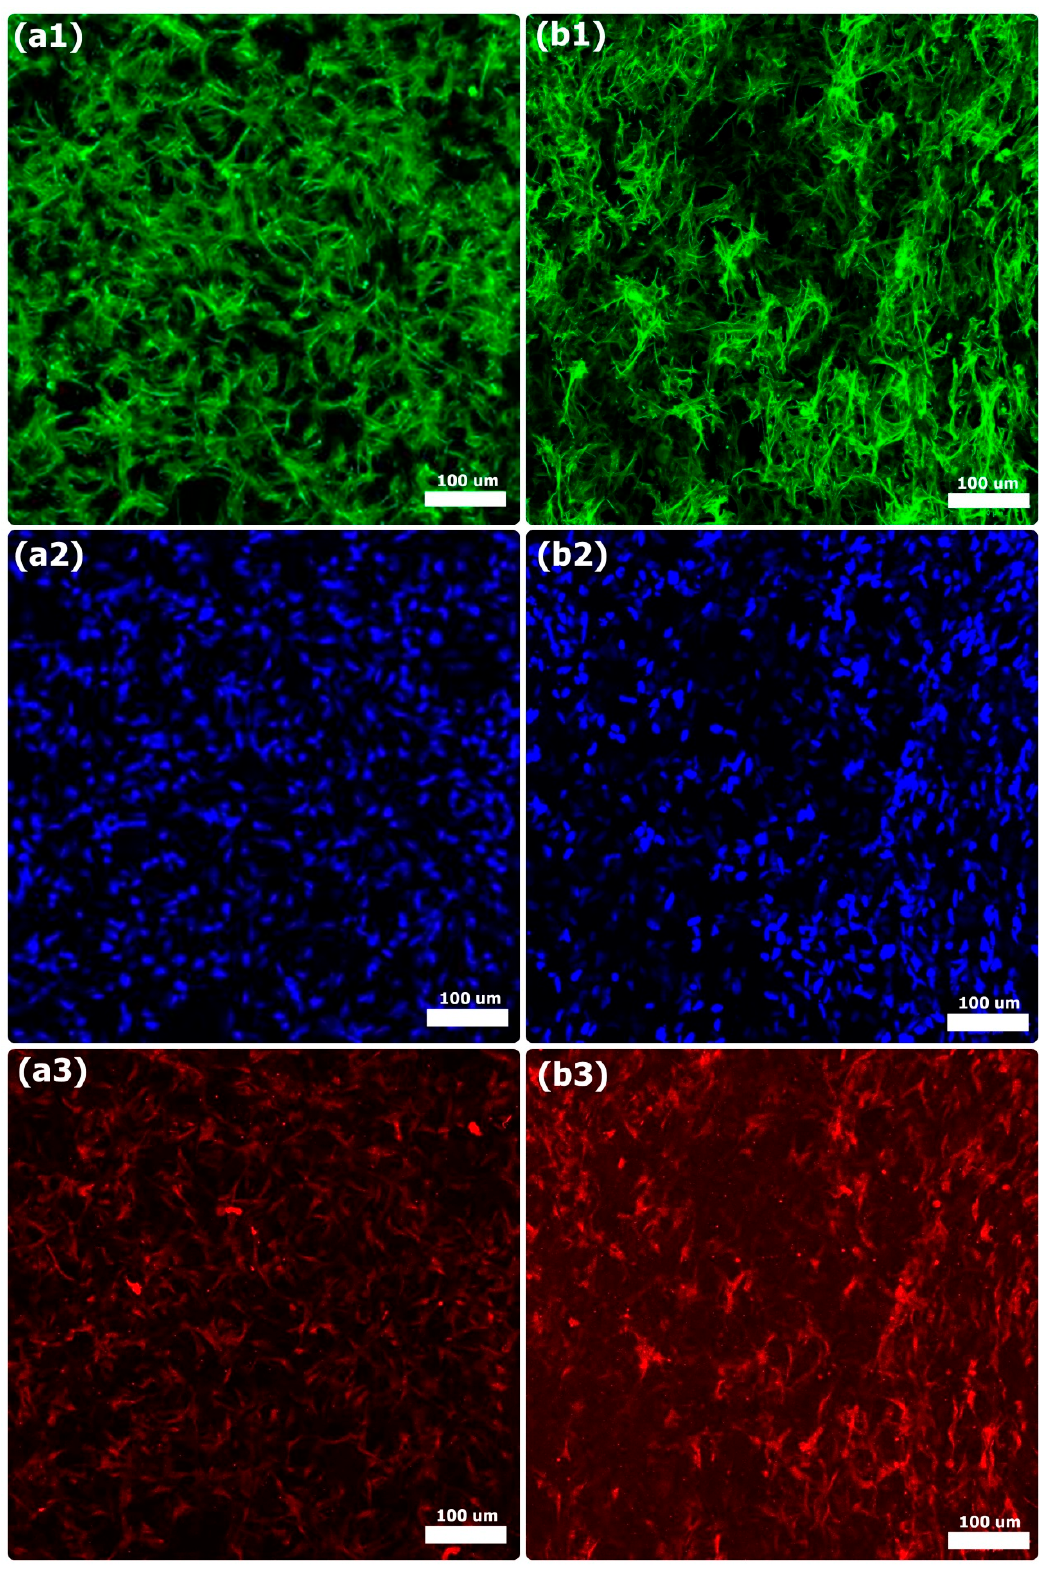
Figure 11. Immunofluorescence analysis of OCN on the ( a1,a2,a3 ) COL scaffold and (b1,b2,b3) COL-HANF scaffold after 14 days of culture. MG63 osteoblast-like cells were stained with OCN (red), cell nuclei were stained with DAPI (blue), and cytoskeletal F-actin was stained with FITC (green). Scale bar = 100 µm.